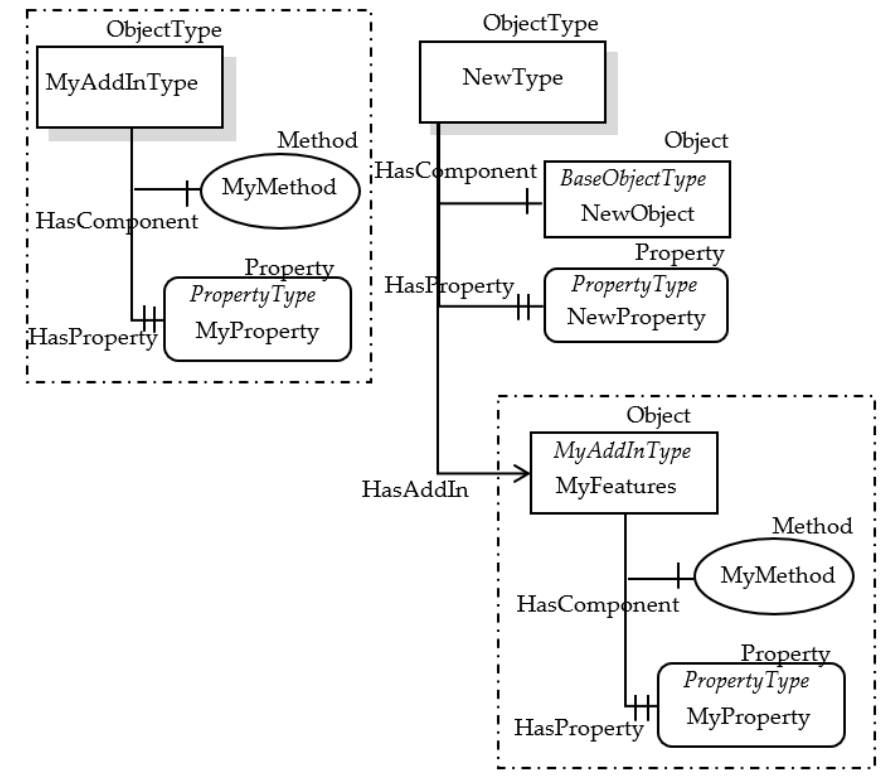
Figure 3. Example of OPC UA AddIn and HasAddIn